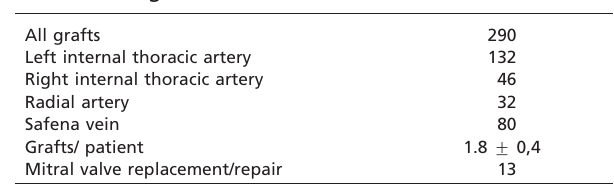
Table 3 - Surgical treatment.